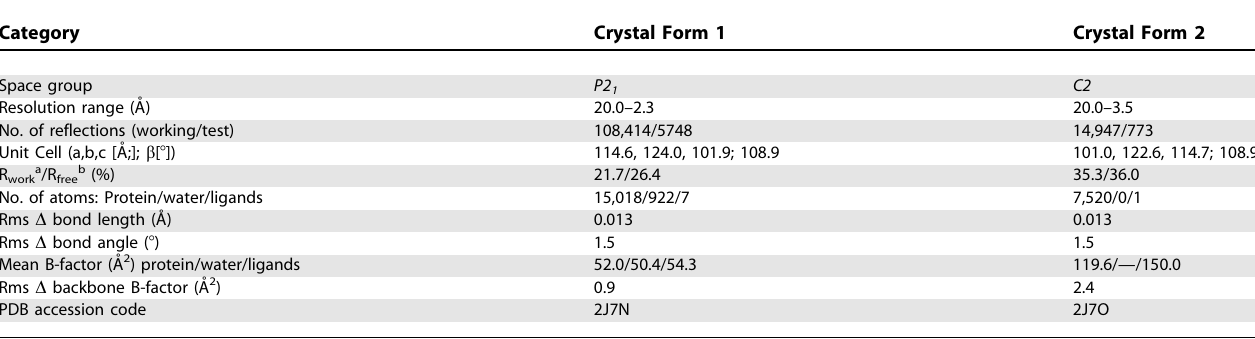
Table 1. Refinement